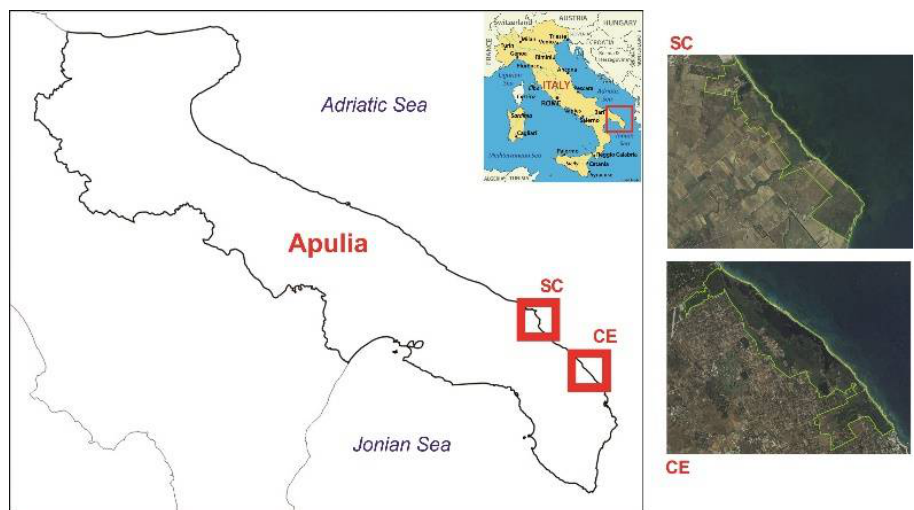
Figure 1. Geographical location and administrative boundaries of the two study areas.